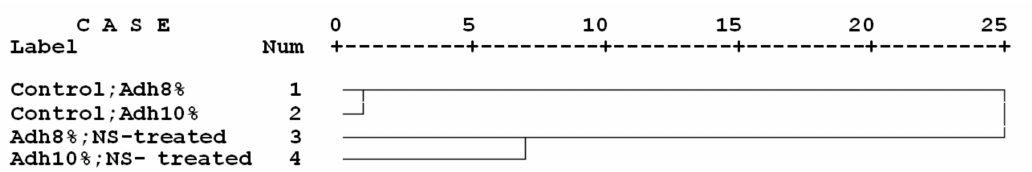
Figure 11. Cluster analysis of the four treatments based on thermal conductivity coe ffi cient, final temperature, and hardness values (Adh = adhesive content; NS =